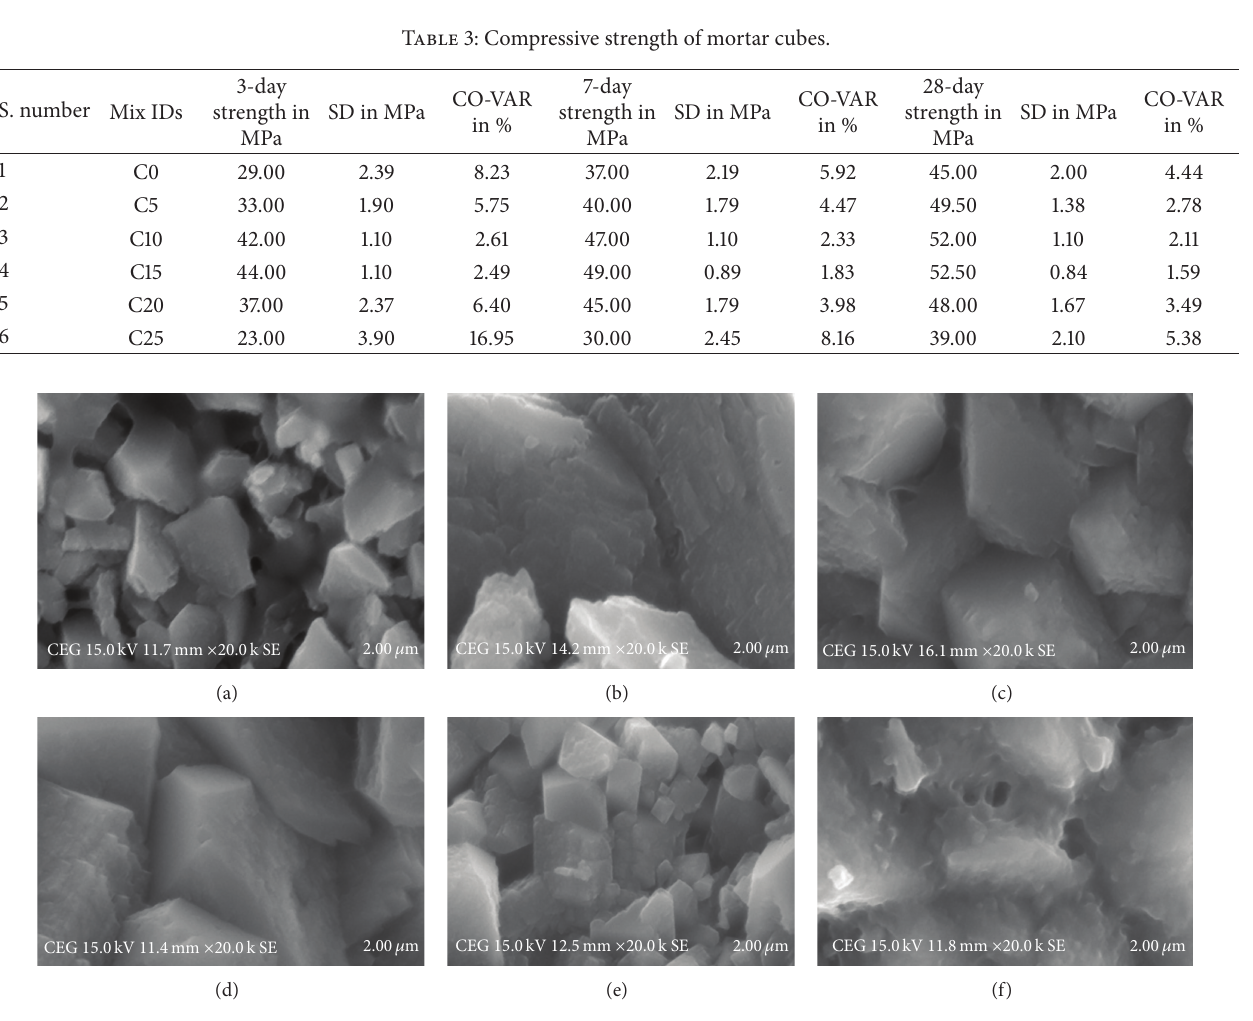
Figure 2: SEM images of specimens with 20000 x magnification: (a) C0 specimen, (b) C5 specimen, (c) C10 specimen, (d) C15 specimen, (e) C20 specimen, and (f) C25